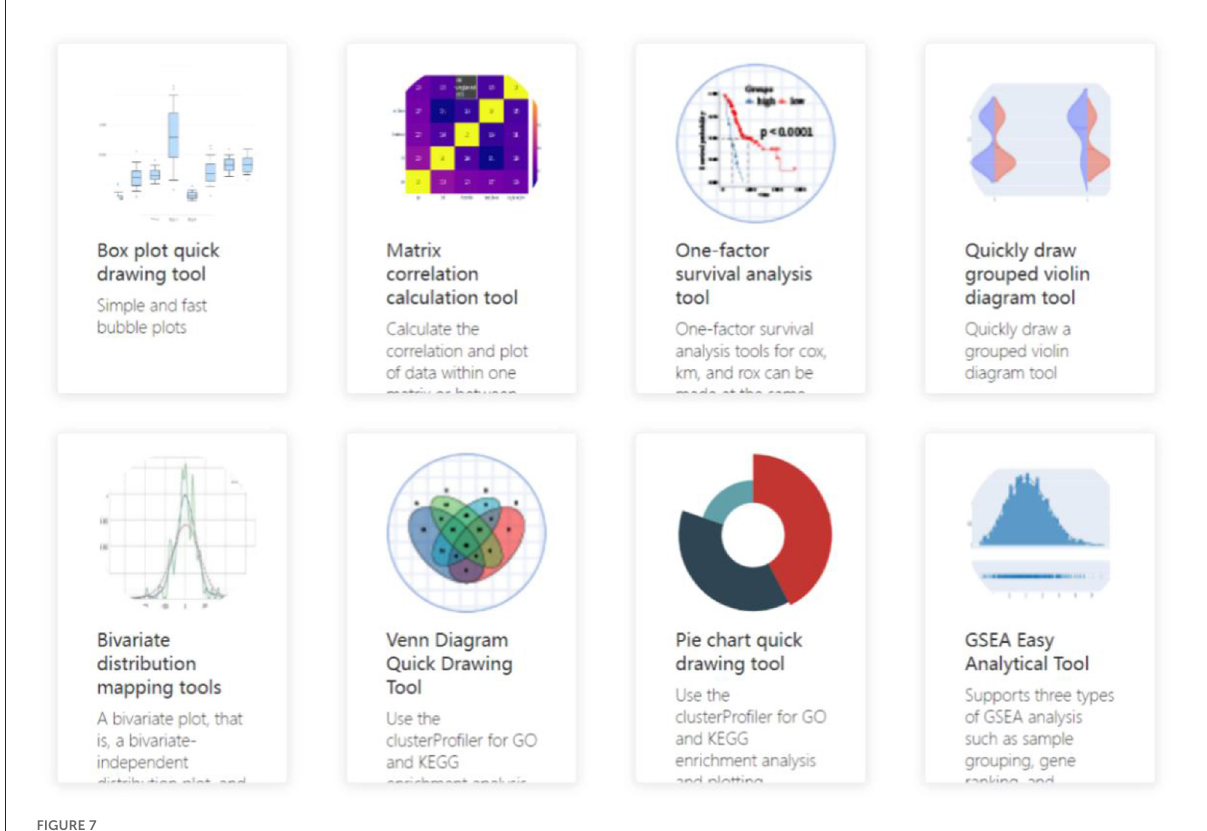
FIGURE7 Data analysis tool